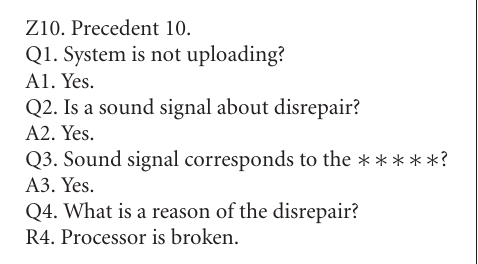
Algorithm 4: QA-program of confirmation.